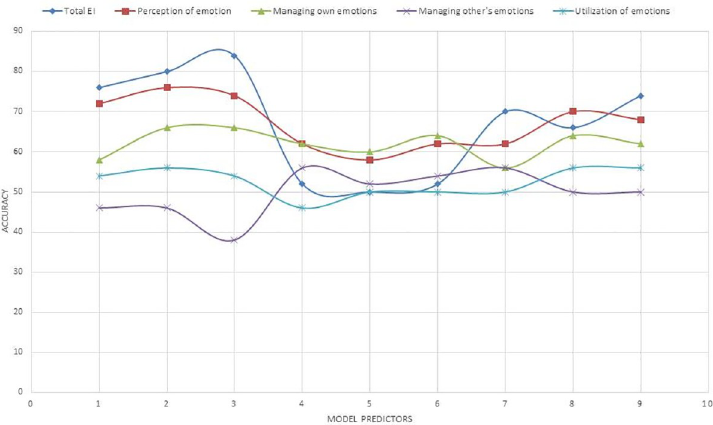
Fig 9. Model accuracy with linear SVM and PCA for different sets of predictors. 1: Cardiac response; 2: Cardiac reactivity; 3: Cardiac response and reactivity; 4: Respiratory response; 5: Respiratory reactivity; 6: Respiratory response and reactivity; 7: Autonomic (cardiac + breath) response; 8: Autonomic reactivity; 9: Autonomic response and reactivity.